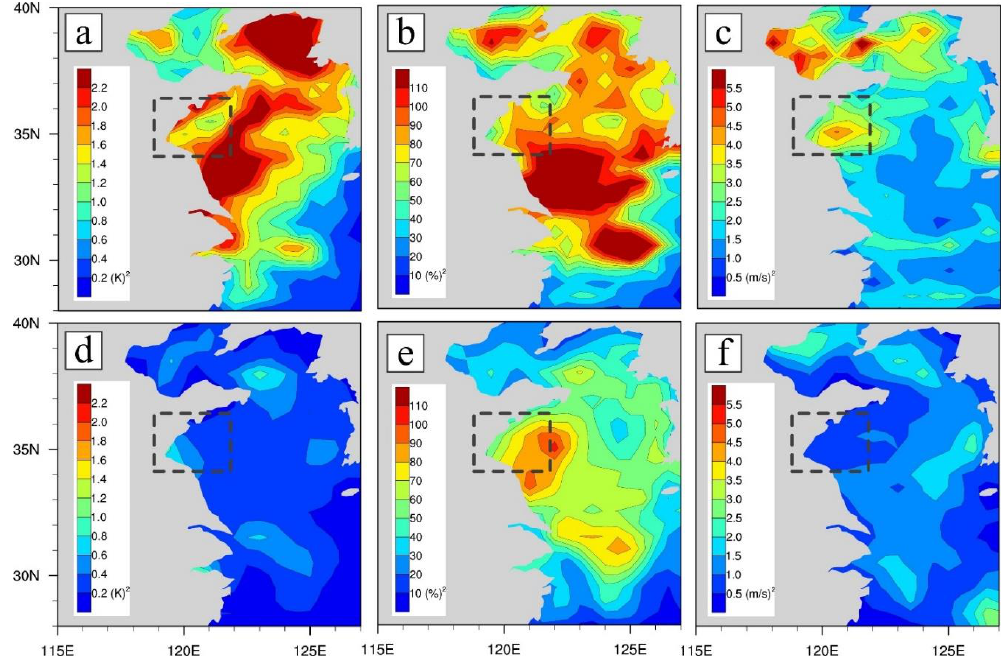
Figure 14. ( a – f ) As in Figure 13, but for Exp-B1 and Exp-B3 of the case C-14.